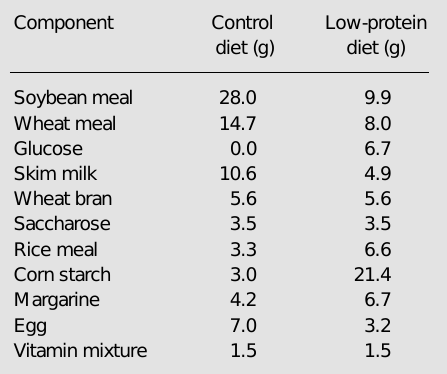
Table 1 - Composition of control (20%) and low- protein (10%)